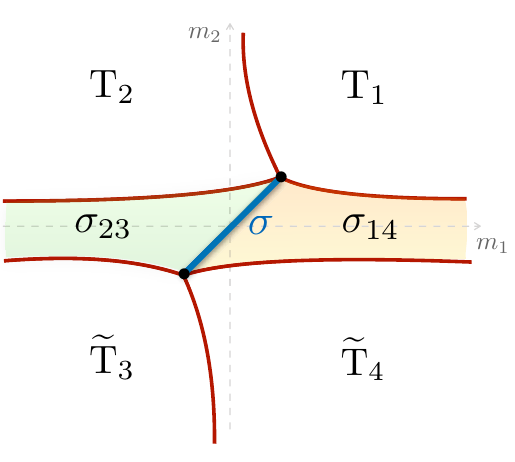
Figure 5 . Phase diagram of SU ( N ) k + p ψ 1 + ( F − p ) ψ 2 in the case 0 ≤ k < F/ 2 − p